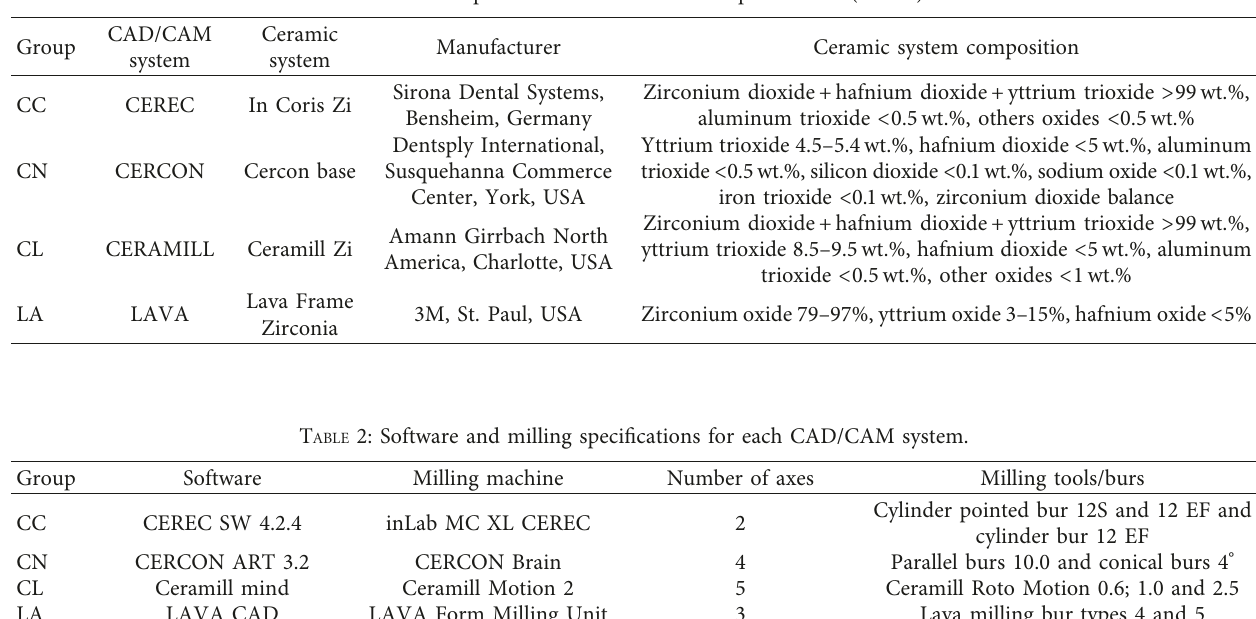
Table 1: Group distribution and material specification ( n � 10).